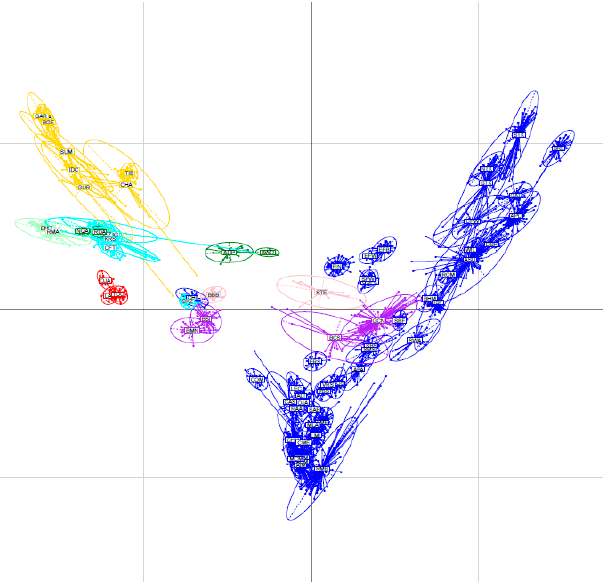
Figure 5. Results of the principal component analysis (PCA) obtained using genotyping data from the WORLD-set (2776 individuals from 77 populations including the 4 Senegalese sheep breeds, genotyped for 40,916 SNPs). The individuals are plotted on the first two principal components according to their coordinates. Ellipses characterise the dispersion of each population around the centre of gravity. Populations are coloured according to their geographic origin (i.e., in blue for Europe, in purple for America, in pink for the Caribbean, in yellow for Asia, in cyan for the Middle East, in light green for East Africa, and in dark green for South Africa). The proximity between Senegalese sheep breeds and some Brazilian breeds (i.e., Mo- rado Nova and Santa Ines) and a Caribbean hair sheep breed (i.e., Barbados Black Belly)